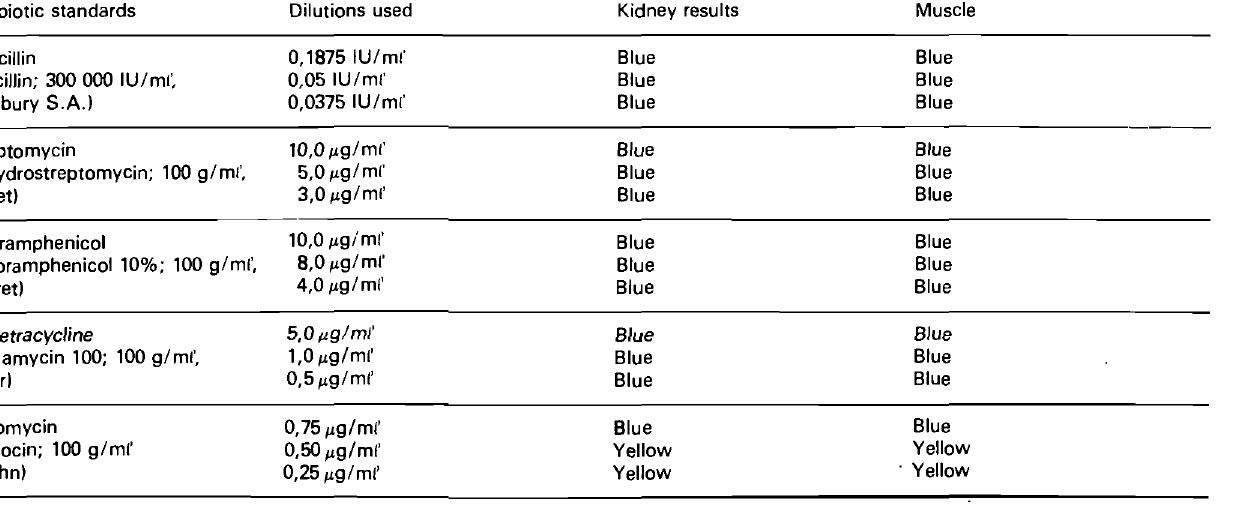
Table 1: Antibiotic standards, dilutions used and results of preliminary